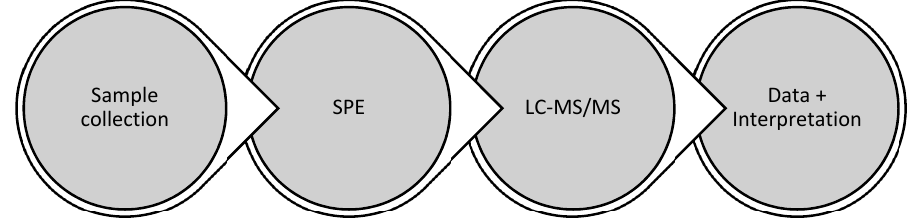
Figure 1. Graphical workflow for sample